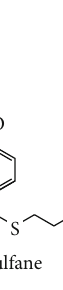
Figure 1: The structure of